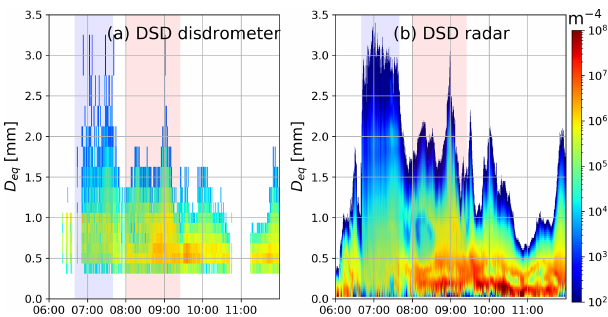
Figure 4. (a) DSD measurements at the ground with a Parsivel dis- drometer. (b) DSD retrieved with multi-frequency Doppler spec- tra below the melting zone at ca. 700–800m. The period shaded in blue corresponds to the region of large DFR X-Ka values above the melting layer that indicates aggregation. The period of enhanced Doppler velocities indicating riming is marked in